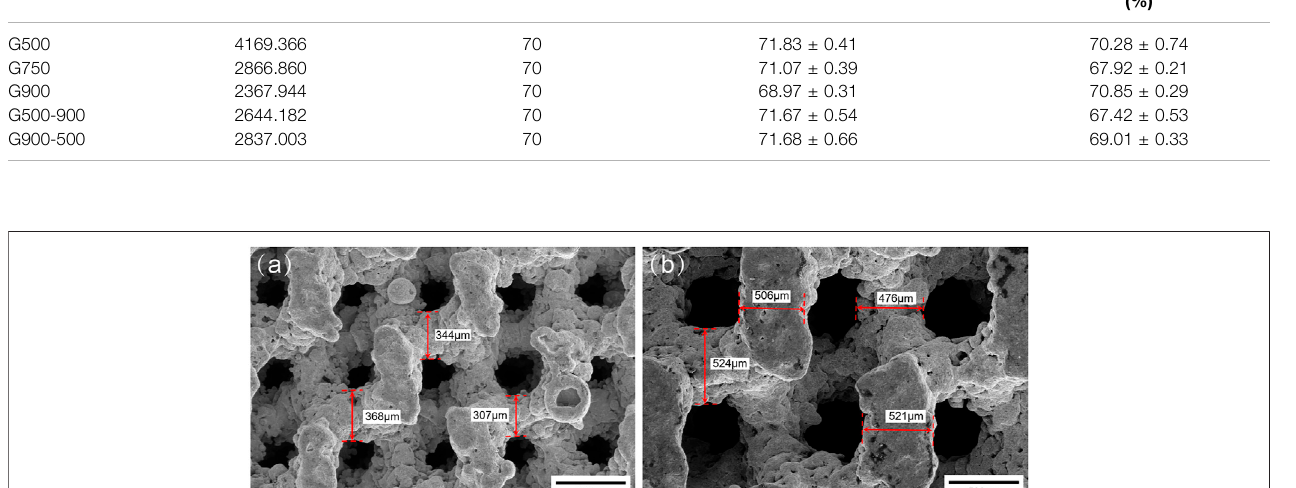
Frontiers in Bioengineering and Biotechnology |